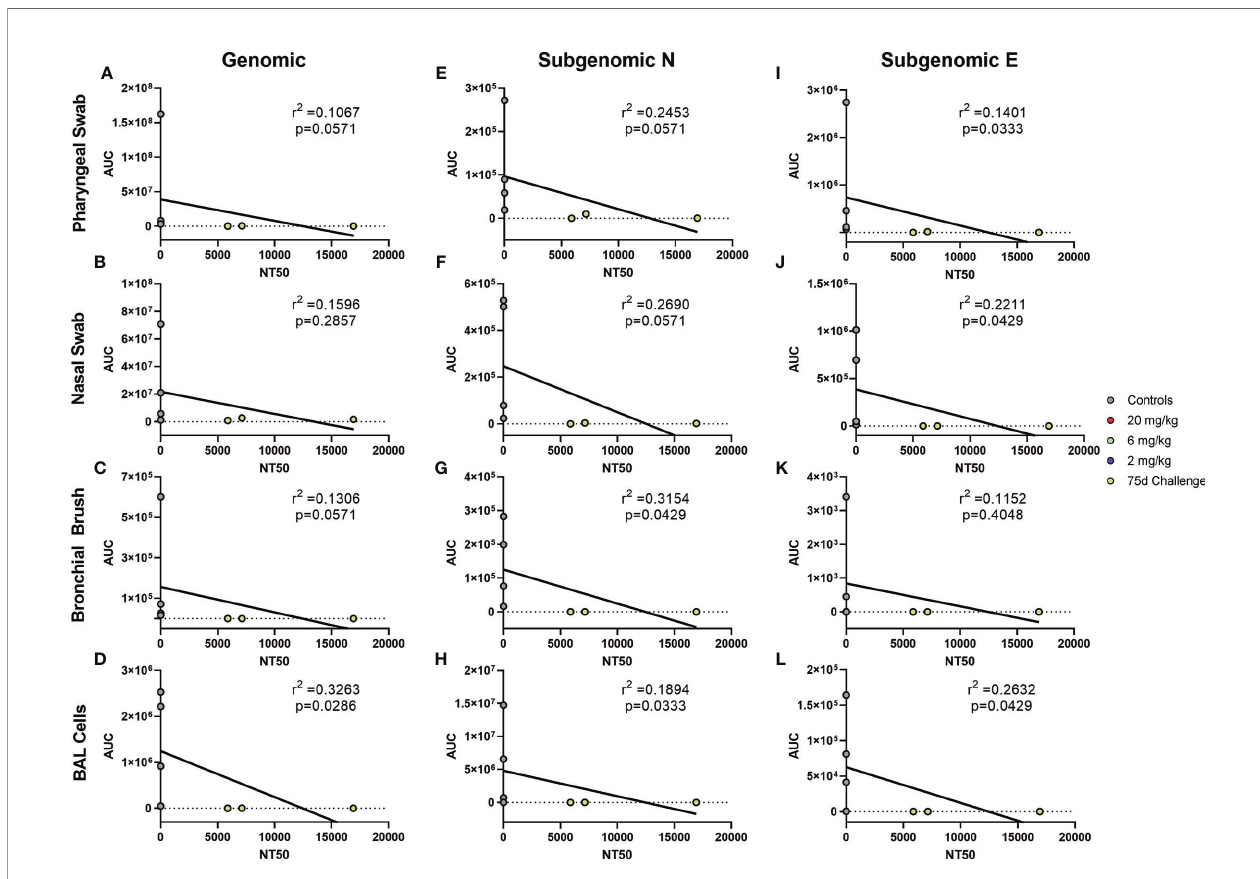
FIGURE 5 | Correlations between Serum Antibodies of 75 Day Challenge Animals and Viral Loads. Viral loads were correlated with neutralization capacity of serum collected one day post challenge from pharyngeal swabs (A, E, I) , nasal swabs (B, F, J) , bronchial brushes (C, G, K) and BAL cells (D, H, L) assessed by RT- qPCR for genomic N (A – D) , subgenomic N (E – H) , and subgenomic E (I – L) content from the 75 day challenge group. The NT50 of each was calculated via pseudovirus neutralization assay presented as reciprocal serum dilution. Nonparametric correlation with linear regression performed to determine the r 2 value for each